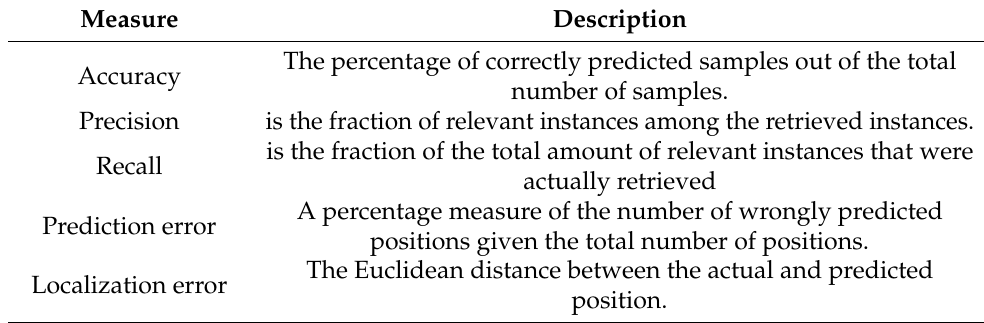
Table 5. Performance